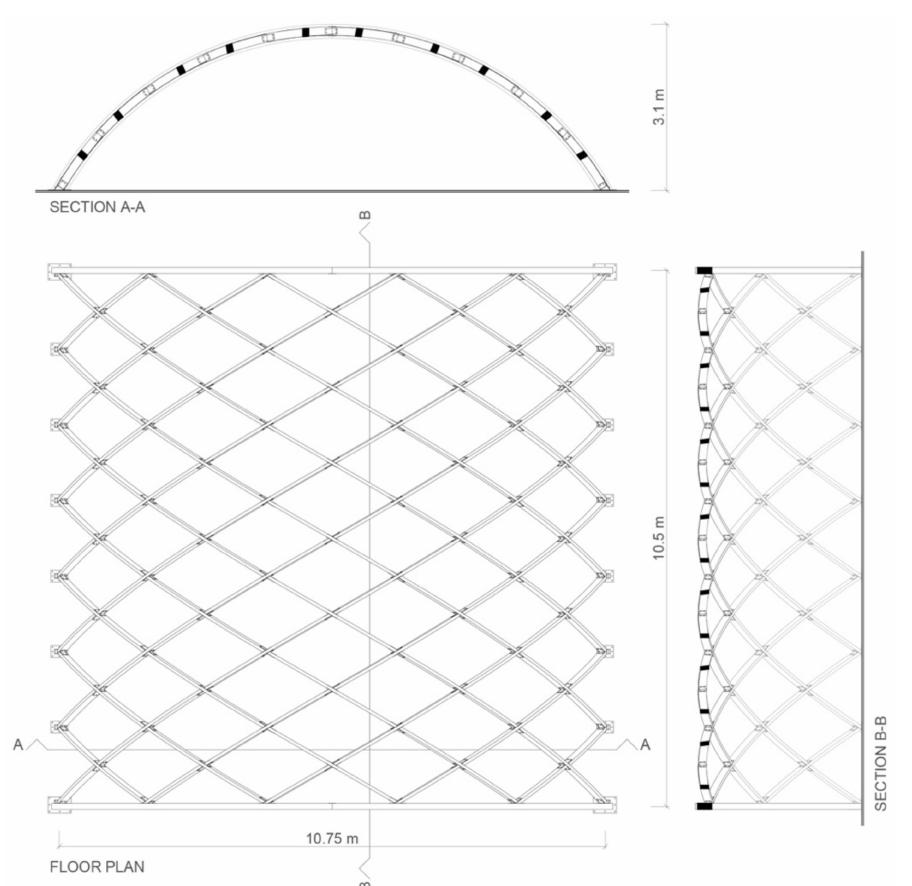
Figure 12. Floor plan and sections of the lamella vault of the physical